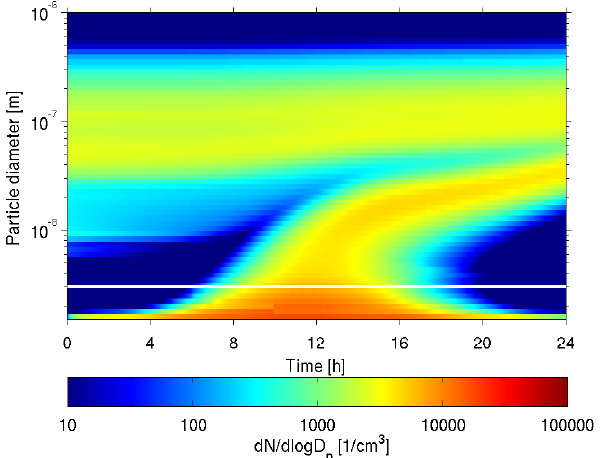
Fig. 4. Comparison of different terms contributing to the Eq. (5) for formation rate. The positive and negative parts of the 1N 3 − 6 /1t term are plotted